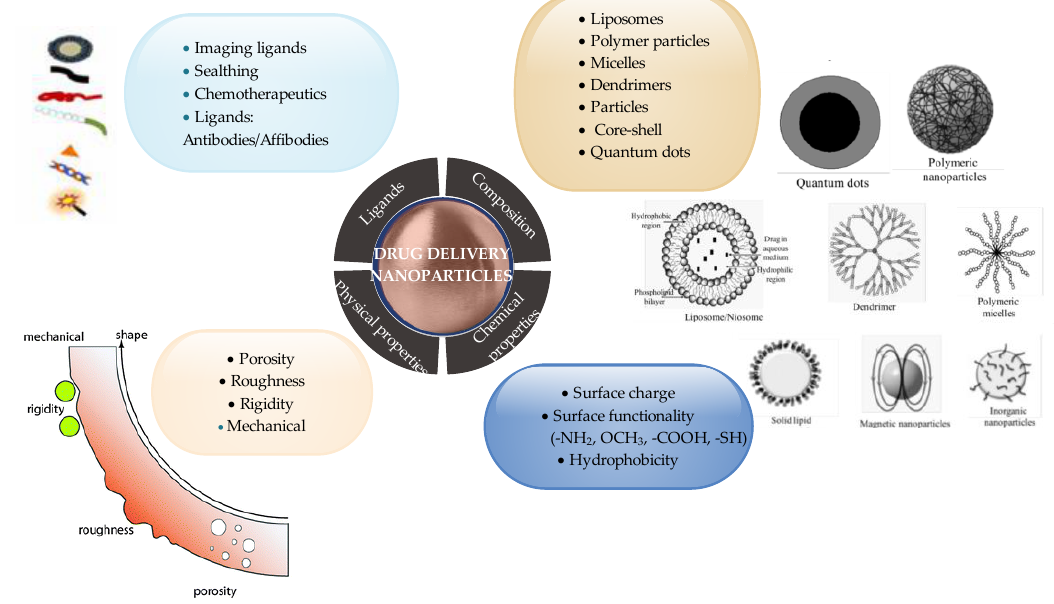
Figure 3. Drug delivery nanoparticles, according to the physicochemical properties and composition of nanoparticles.